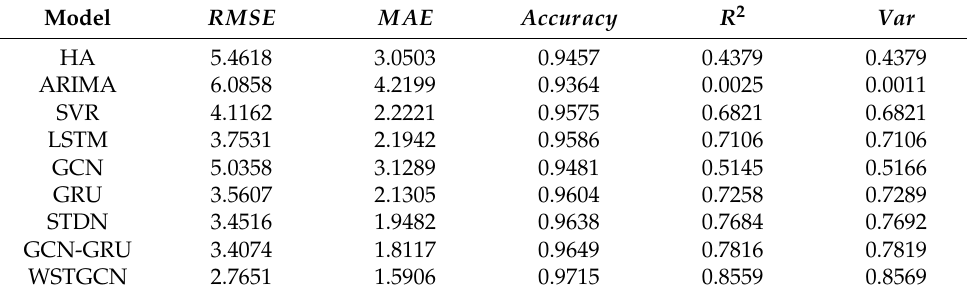
Table 4. Comparison of 30-min speed predictions.